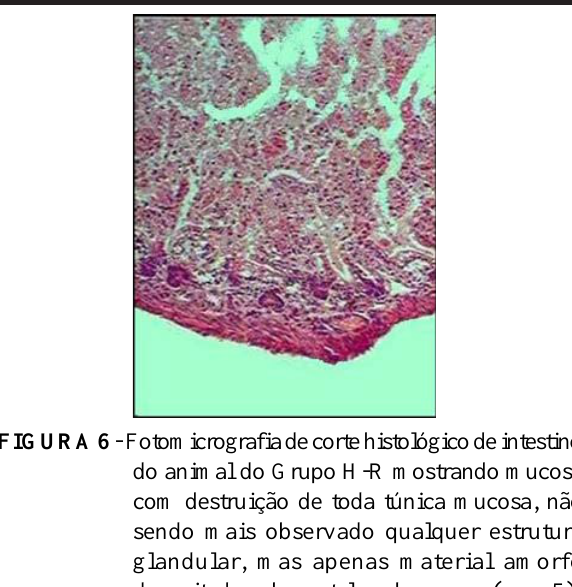
Grau de lesão tecidual no intestino delgado (Tabela 2) Foi encontrada diferença estatisticamente significante entre os grupos de estudo quanto à distribuição do grau de lesão tecidual no intestino delgado dos animais (p < 0,001), onde o grupo G1 apresentou graus significantemente menores do que os dos grupos G2.